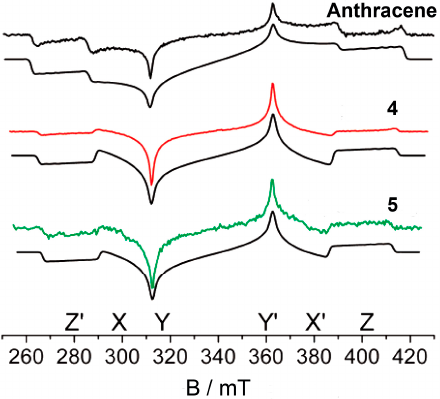
Figure 21. TREPR spectra of the compounds of anthracene, 4 and 5 in toluene at 85 K and the delay time was 900 ns following the excitation at 416 nm (355 nm for An). The canonical orientations of each transition are indicated. Smooth curves below the experimental spectra are simulation results of the triplet spectra. Reproduced with permission from reference [33], copyright 2008, American Chemical Society.